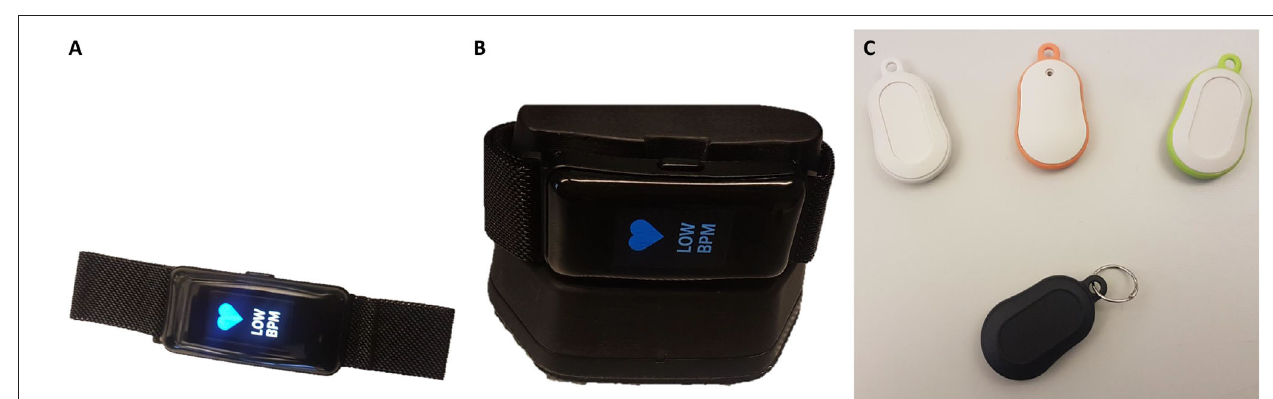
FIGURE 5 | The NESTORE monitoring artifacts: (A) the wearable device; (B) the charging station; (C) the social and environmental beacons.